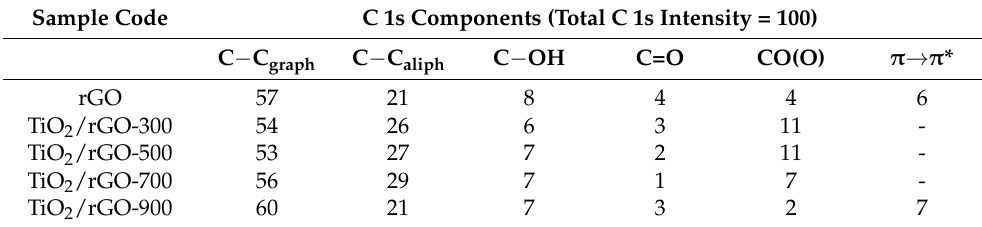
Table 3. The relative surface functional group composition of the total C 1s